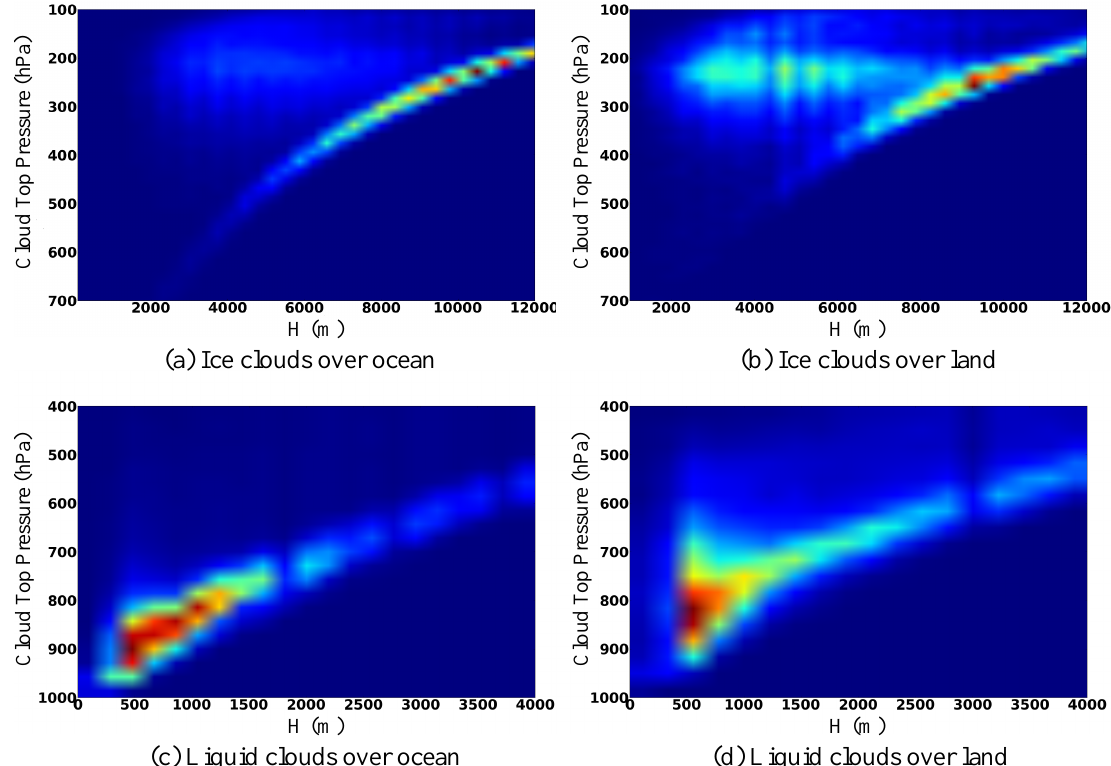
Fig. 4. Climatology of cloud top pressure versus cloud vertical extent for selected monolayered clouds in 2008 based on the 2B-GEOPROF- LIDAR product: over ocean on the left-hand panels, and over land on the right-hand panels. The thermodynamical phase comes from PARASOL and